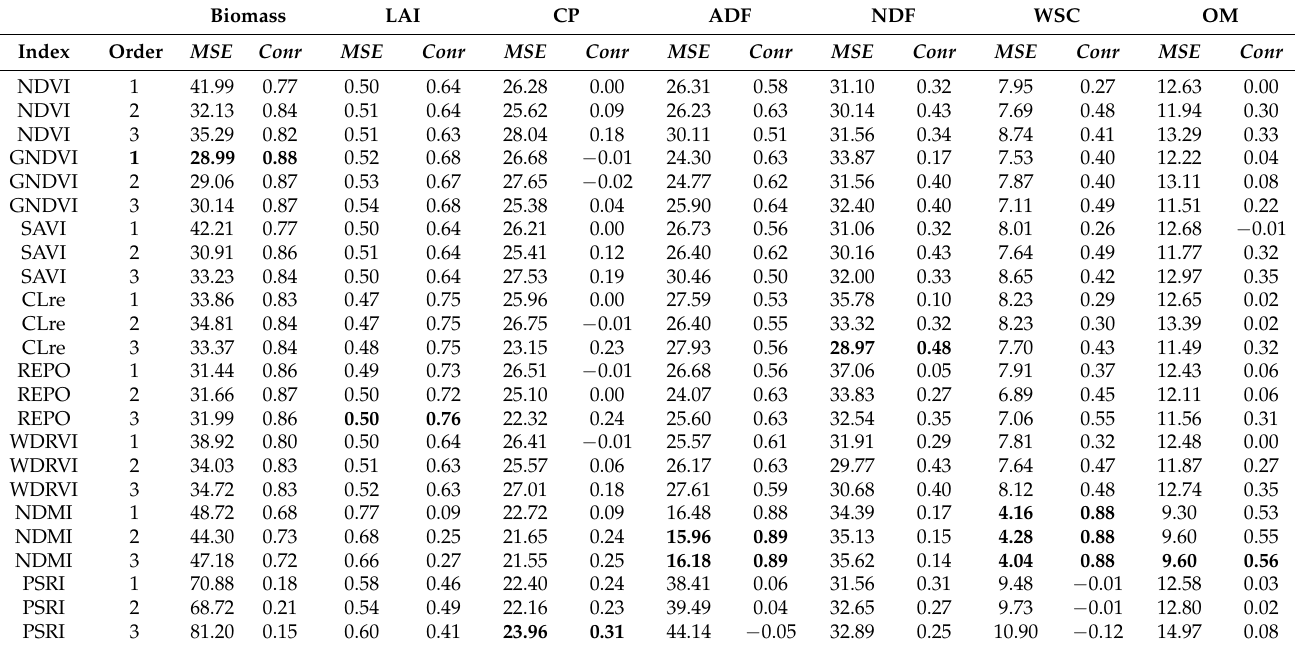
Table 5. Mean square error ( MSE ) and concordance correlation coefficients ( Conr ) for predicting pasture quantity and quality parameters (39 samples for each parameter) using literature-based indices (Table 2). The results in bold highlight models yielding highest Conr